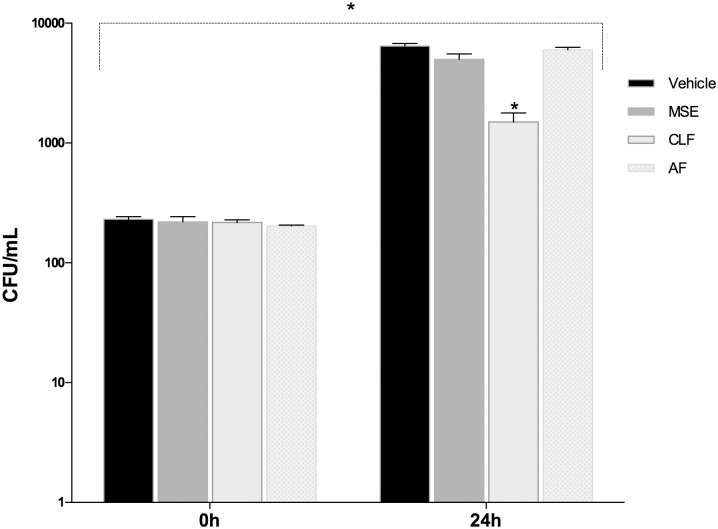
Comparison of colony-forming units.Comparison of colony-forming units (CFU/mL) among groups treated with MSE, CLF and AF after A. actinomycetemcomitans infection. Data are expressed as mean ± SEM using one-way analysis of variance (ANOVA) followed by Dunnet’s multiple comparison tests as compared to vehicle control. The level of statistical significance was set at 0.05.